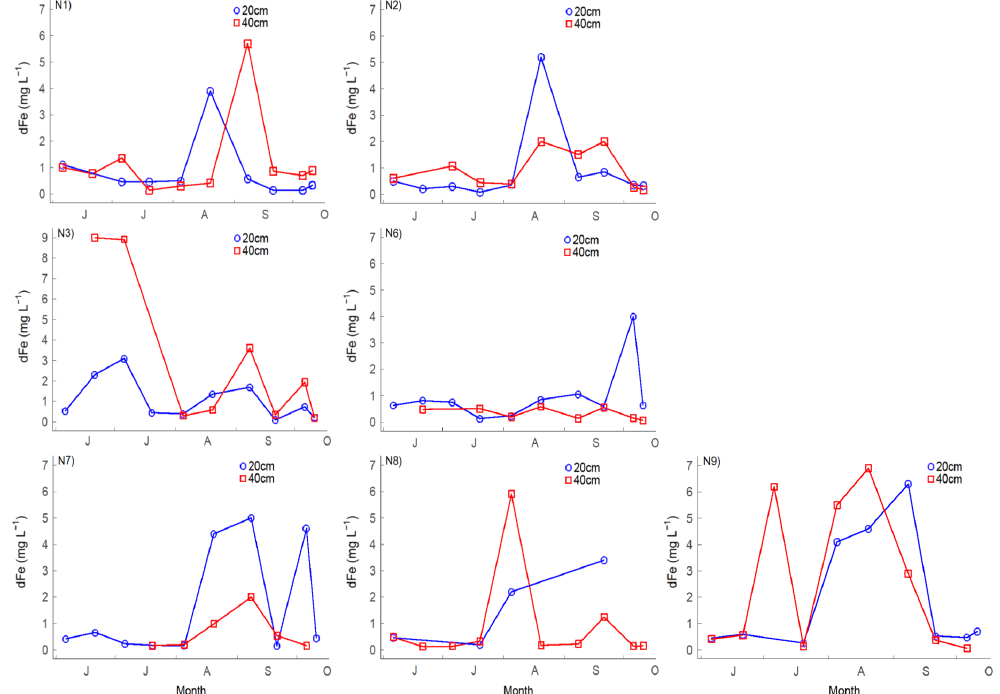
Figure 7. Seasonal changes in dFe concentrations in soil pore waters of 20 cm and 40 cm depths at the points along a transect. Note that the observation at these points started after snowmelt season. There is no result for N5, which is located on steep hillslope because the soil pore water could not be collected throughout the